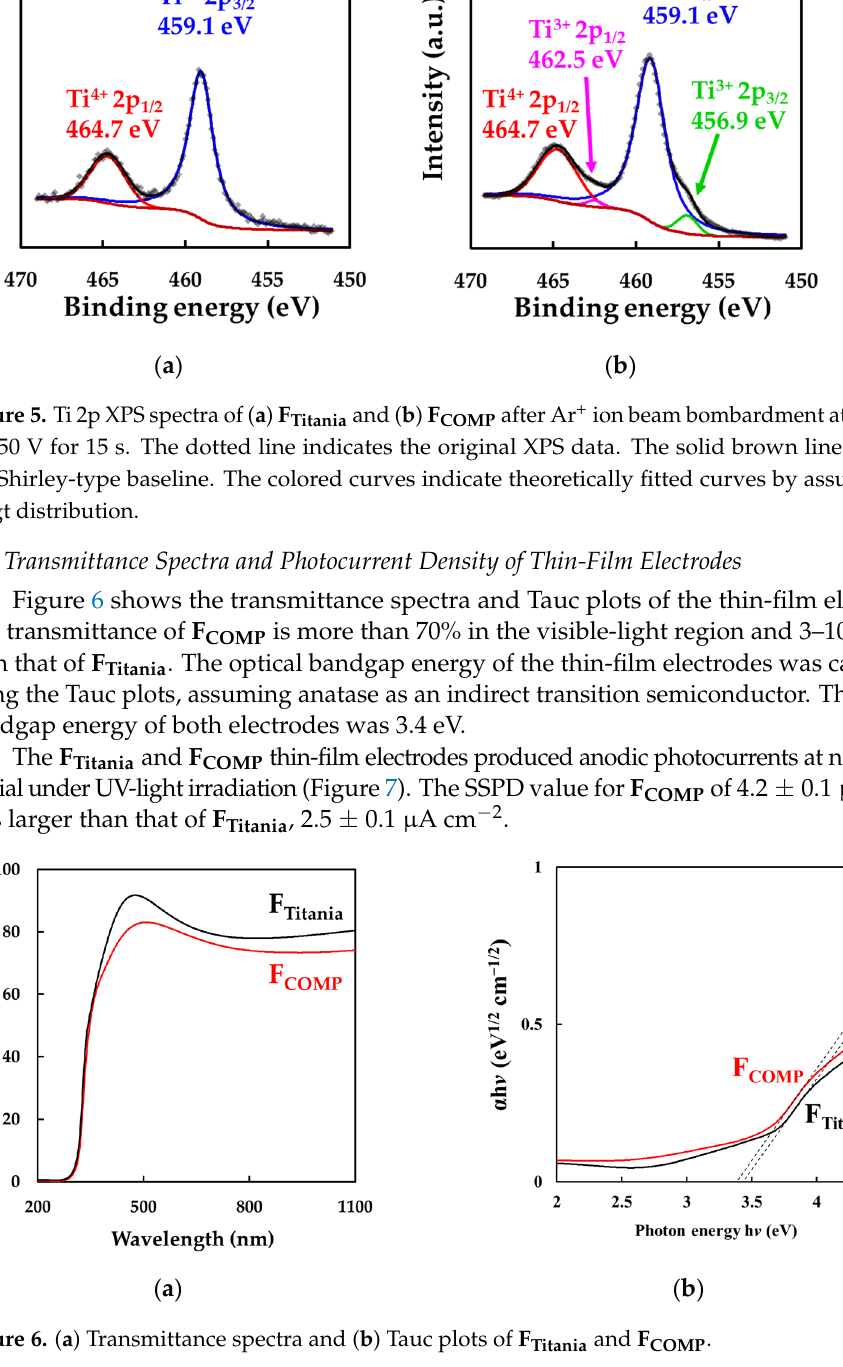
Figure 7. Results of the photocurrent density measurements under dark and UV irradiation of F Titania and F COMP . 4. Discussion 4.1. Preparation of SWCNT/Anatase Precursor Solution and Composite Thin-Film Electrode The SWCNT/titania precursor solution, S COMP , remained a stable SWCNT-dispersed solution for more than several months under ambient conditions. It is generally difficult to disperse CNTs uniformly in composite precursor solutions using the sol–gel method because they tend to aggregate owing to the intermolecular attractive forces, that is, van der Waals forces, between CNT molecules; reducing the surface energy and van der Waals forces can improve the dispersibility of CNT molecules [22,23]. In addition, the van der Waals interaction energy between two single molecules is very small, but that between two particles consisting of many molecules is large [24]. Molecular precursor solutions